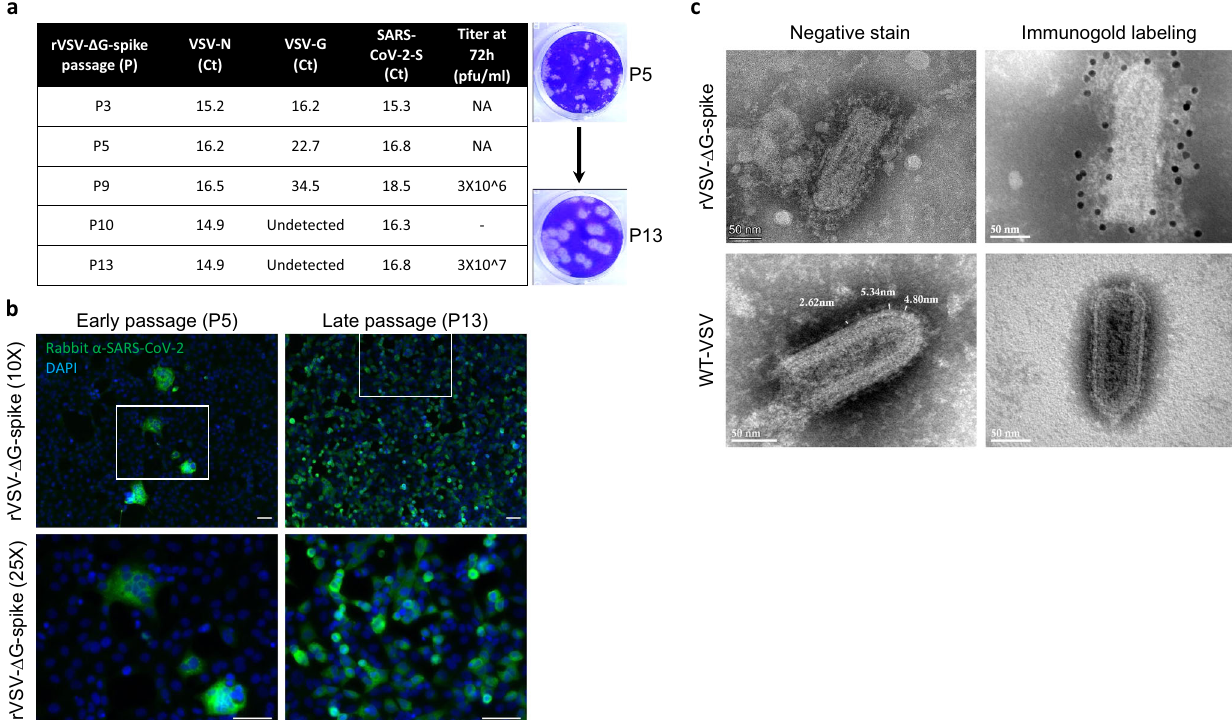
Fig. 2 Characterization of rVSV- Δ G-spike. a A table summarizing the genome analysis of several passages of rVSV- Δ G-spike, showing elimination of VSV-G over time, together with increased titer, and formation of plaques. NA not applicable. “ - ” not evaluated. b Representative immuno fl uorescence images of Vero E6 cells infected with early passage (P5)-rVSV- Δ G-spike, or late passage (P13)-rVSV- Δ G-spike, stained with a SARS-CoV-2 antibody (green), and counterstained with DAPI for nuclei staining (blue). Bottom panels show insets at large magni fi cation. Scale bars: 50 µ m. rVSV- Δ G-spike at P5 formed syncitia, whereas P13 showed individual infected cells, with no evidence of syncitia. c Transmission electron micrographs of P14 rVSV- Δ G-spike (top panels) compared to WT-VSV (bottom panels). Right panels show immunogold labeling using gold nanoparticles conjugated antibodies directed to the spikes ’ RBD. Data for b and c are representative of four and fi ve experiments,